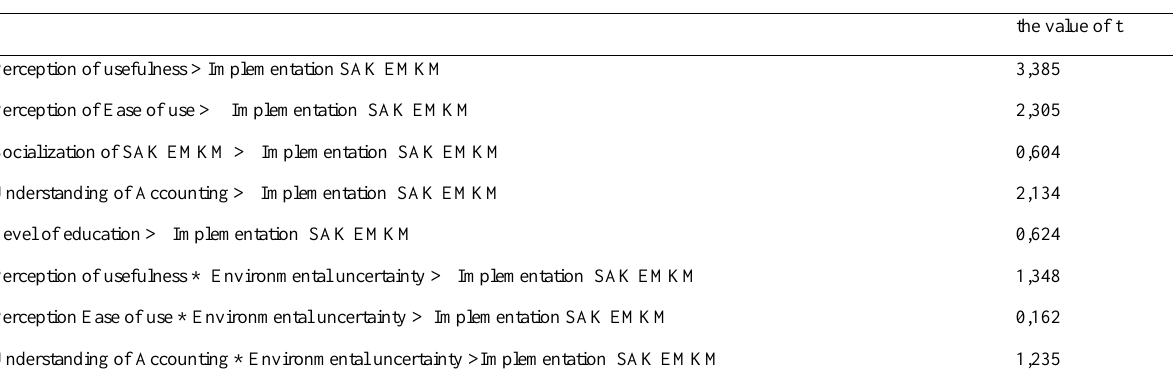
Tabel 3: Total Effect